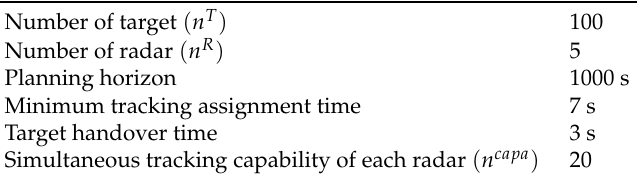
Figure 11. Conceptual diagram for the battlefield scenario. Table 6. Parameter set for battlefield scenario experiment.